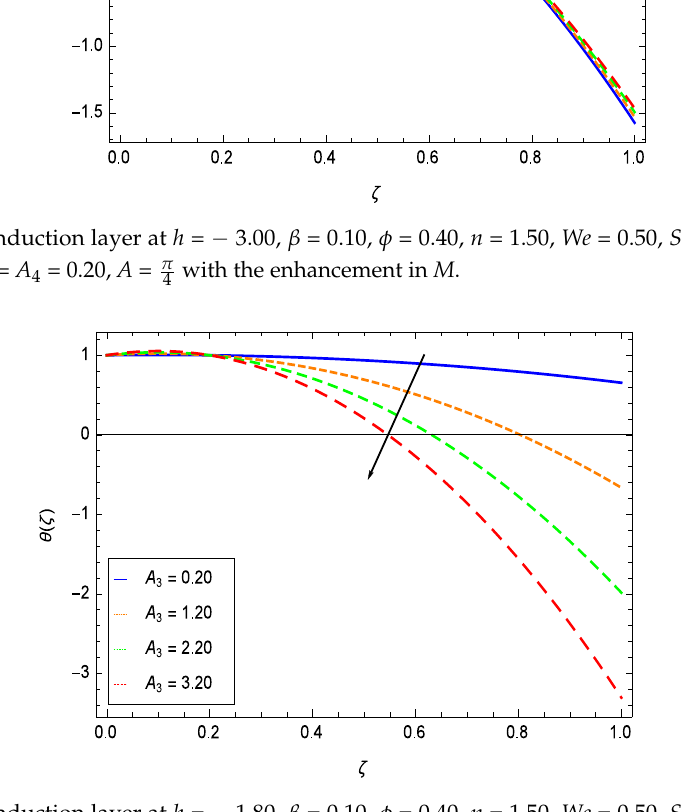
Figure 15. Conduction layer at h = − 1.80, β = 0.10, φ = 0.40, n = 1.50, We = 0.50, S = 0.50, Nr = 1.00, M = 2.00, Pr = 10.00, A 4 = 0.20, A = π with the enhancement in A 3 4